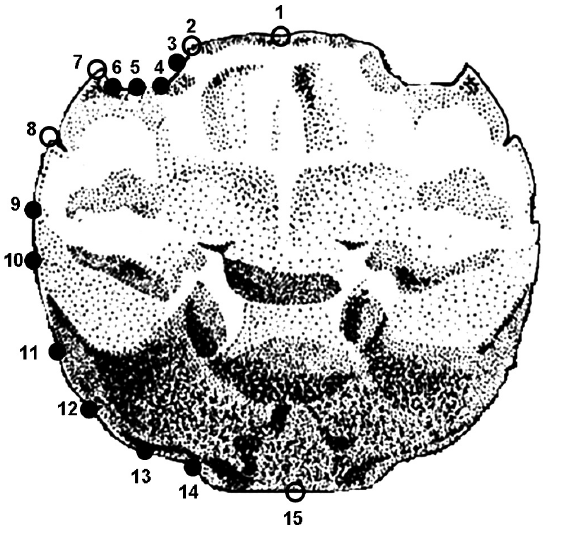
Fig . 1. – Landmarks configurations on the Cyrtograpsus carapace. Empty and full circles represent anatomical landmarks and semi- landmarks, respectively. Landmarks 1 and 15 marks the anterior and posterior edge of the carapace, respectively; landmarks 2 and 7 are located on the internal and external border of the ocular depression, respectively; and landmark 8 indicates the first lateral teeth. Semi- landmarks described the general contour of the carapace. Figure adapted from Boschi et al .,